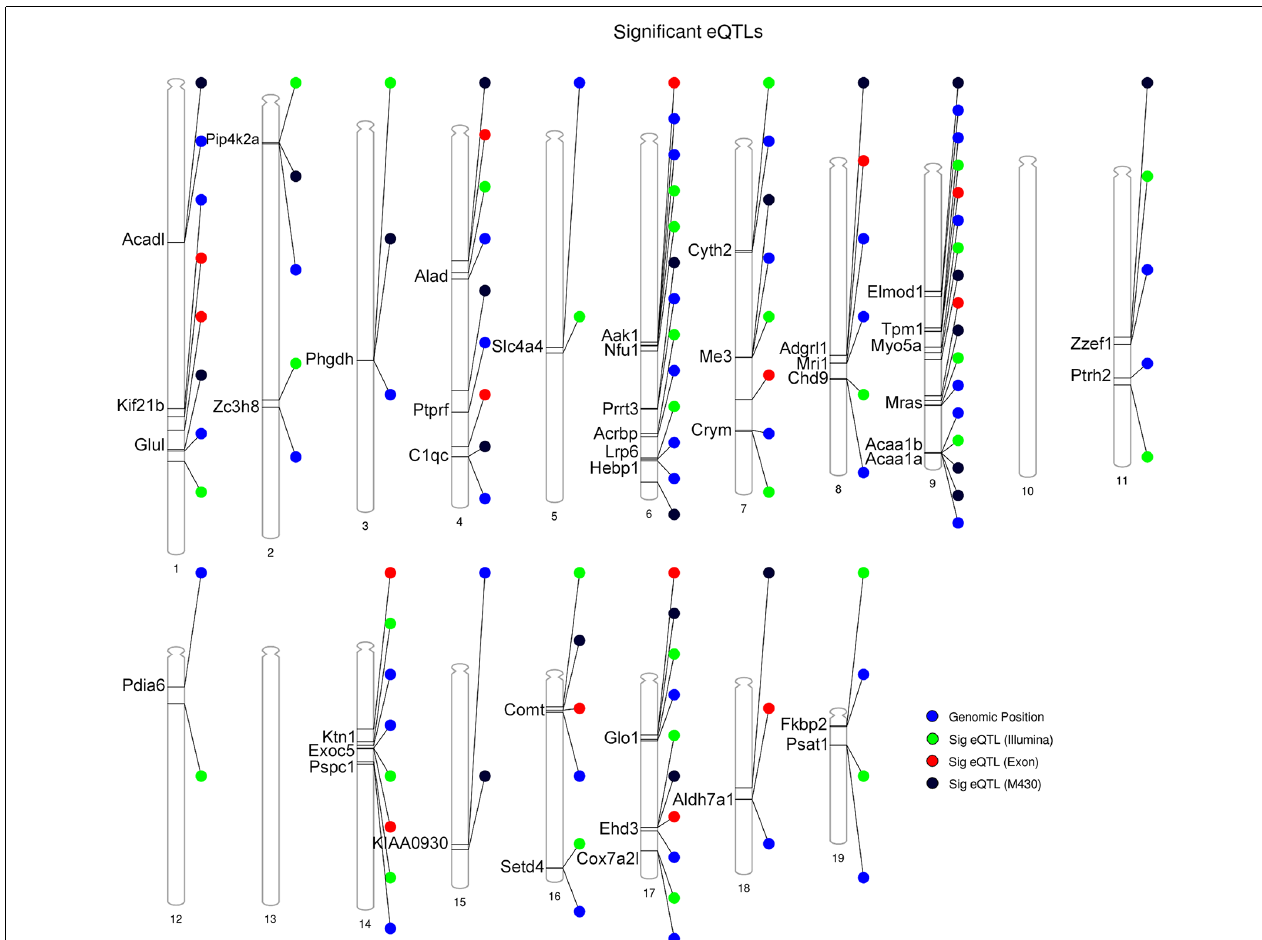
FIGURE 4 | Summary of DE proteins whose transcripts demonstrate significant local modulation by a cis eQTL in the BXD family. Gene position for DE proteins indicated by the blue circle. Position of peak markers significantly associated with cognate gene expression is provided for each striatal microarray expression platform. Illumina = Illumina mouse-6 v1.1 expression beadchip array; the M430 = Affymetrix Mouse Genome 430 2.0 array; Exon = Affymetrix Mouse Exon 1.0 ST Array. Genome-wide significance of marker associations based on 1,000 permutations. Thirty genes demonstrate the same strain effect on both transcript and protein levels (e.g., higher expression associated with the B6 allele relative to the D2 allele). Thirteen genes demonstrate mismatched expression: Acrbp , Adgrl1 , Chd9 , Cox7a2l , Hebp1 , Nfu1 , Prrt3 , Psat1 , Pspc1 , Ptprf , Slc4a4 , Zc3h8 , and Zzef1 .